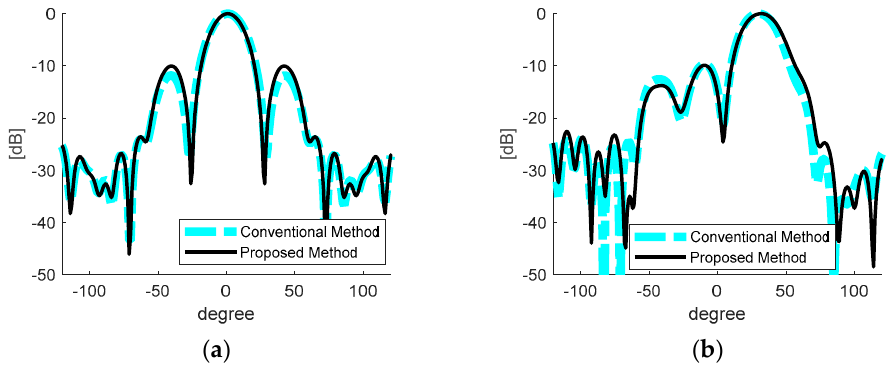
= = calculated by the proposed method (solid calculated by the proposed method (solid = calculated by the proposed method (solid